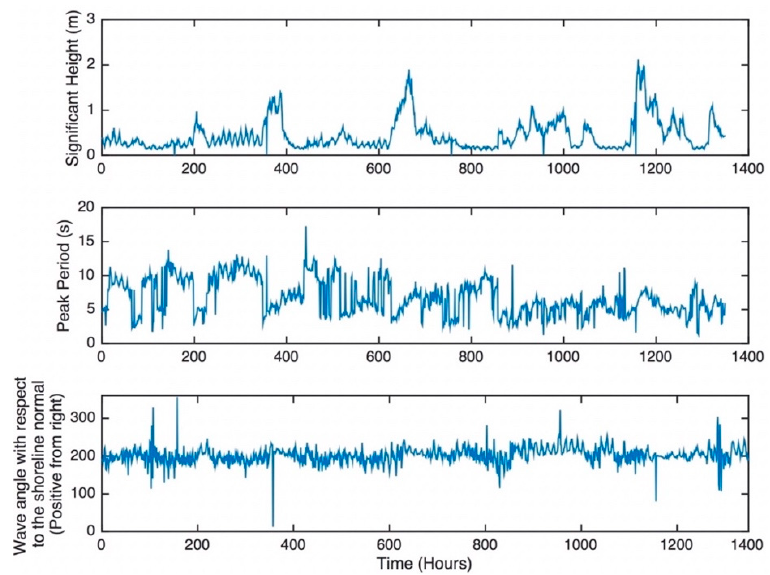
Figure 12. Time history of significant wave height, peak period and wave angle.